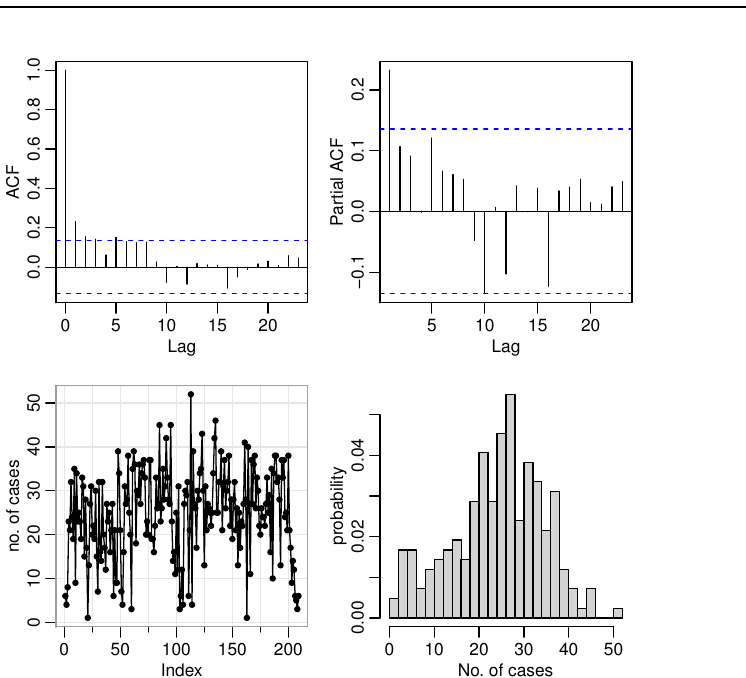
Figure 3. ACF, PACF, time series, and histogram plots of weekly number of syphilis cases